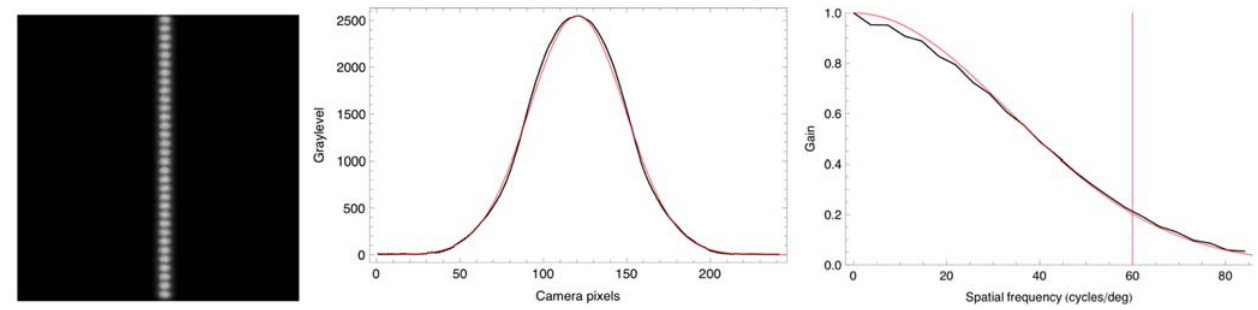
Figure 19. Estimation of display MTF. A) Captured image of a vertical line on the CRT display (graylevel=255). B) The linespread function obtained by averaging the image over columns of pixels. The red curve is a Gaussian fit. C) MTF obtained as the Discrete Fourier Transform of the linespread function. The red curve is a Gaussian fit.